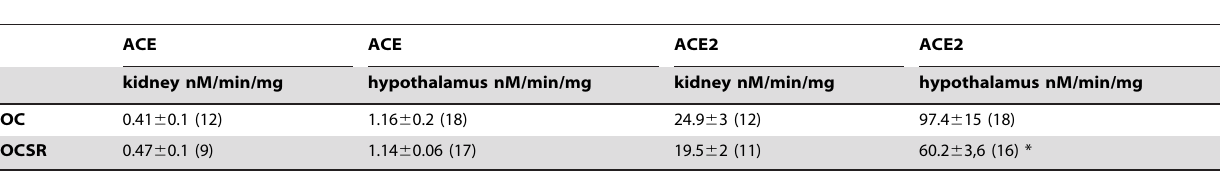
Table 4. ACE and ACE2 activity in hypothalamus and kidney